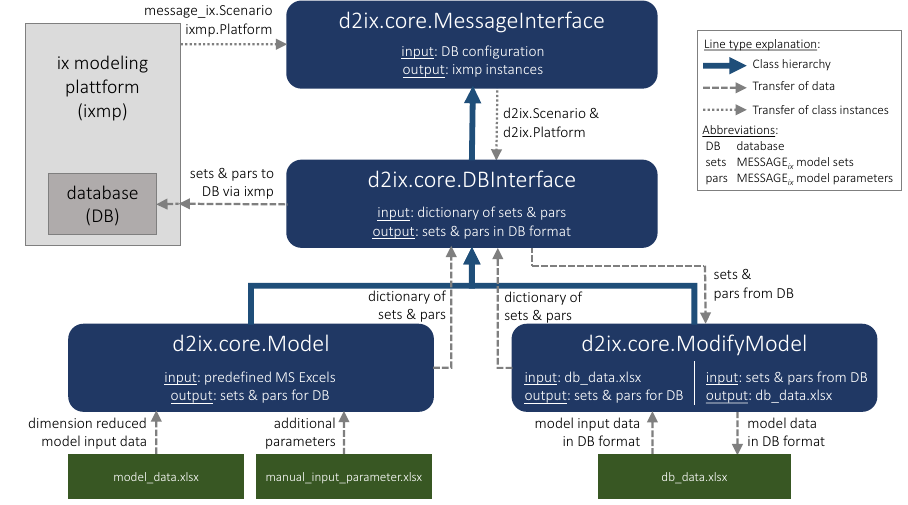
Figure 4. Class hierarchy diagram of the d2ix